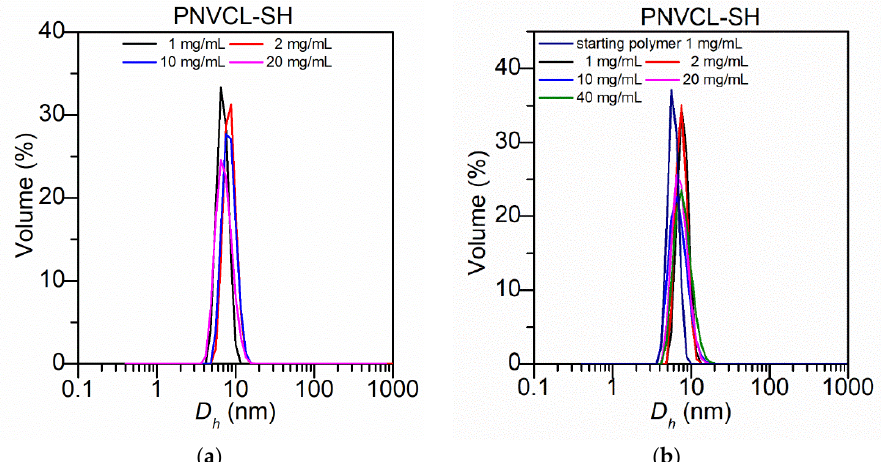
Figure 5. DLS measurements. Evolution of the D h of linear PNVCL-SH polymers in ( a ) THF and ( b ) H 2 O.